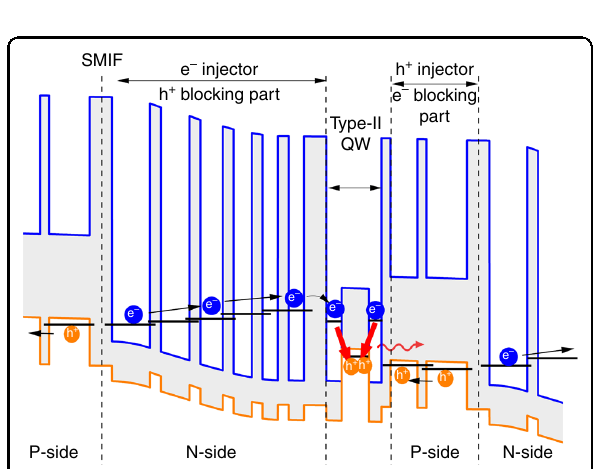
Fig. 12 Band structure of a typical ICL. Adapted from ref. 38 , used